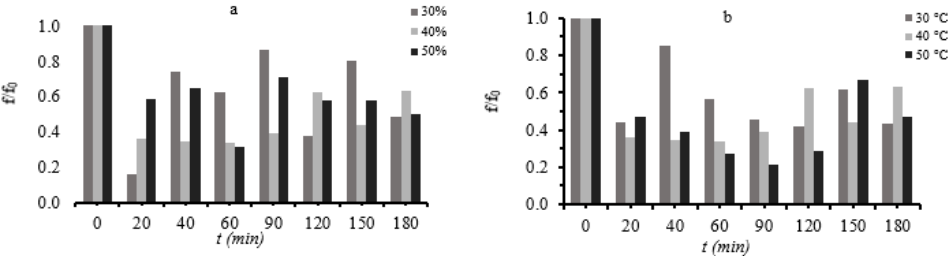
Figure 8. ( a ): Relative hardness change (f/f 0 ) during osmotic dehydration at 40 °C, at all three different glycerol concentration and ( b ): hardness (f) during osmotic dehydration at 40% glycerol concentration, at all three different temperatures.